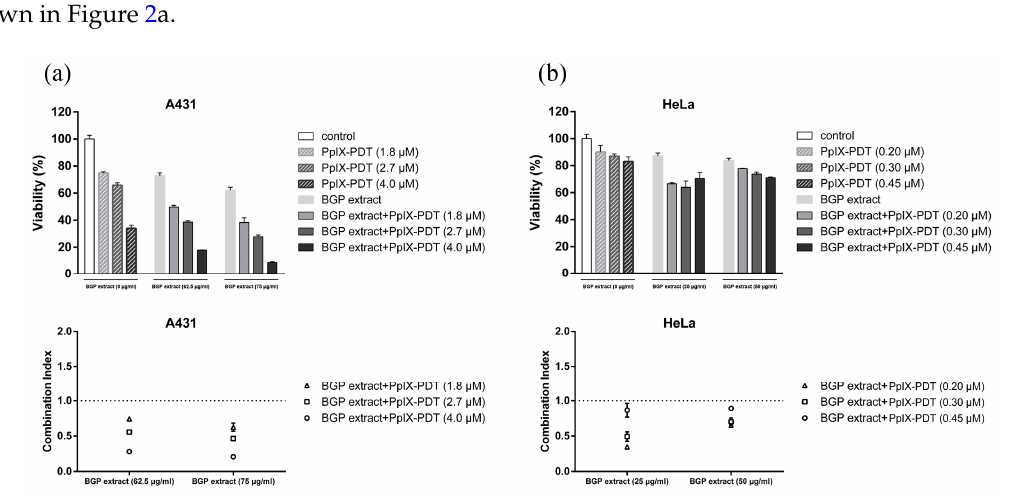
Figure 2. Brazilian green propolis (BGP) extract enhanced protoporphyrin IX (PpIX)-mediated photocytotoxicity in vitro. Combined effects of BGP extract and PpIX-mediated PDT (PpIX-PDT) in